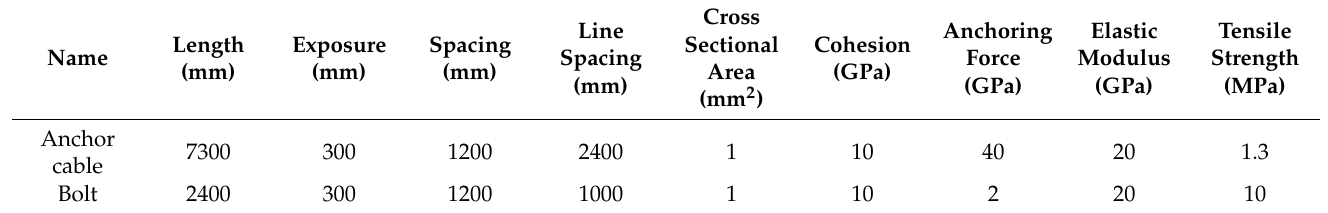
Table 2. Basic physical and mechanical parameters of anchor cable and anchor in main inclined